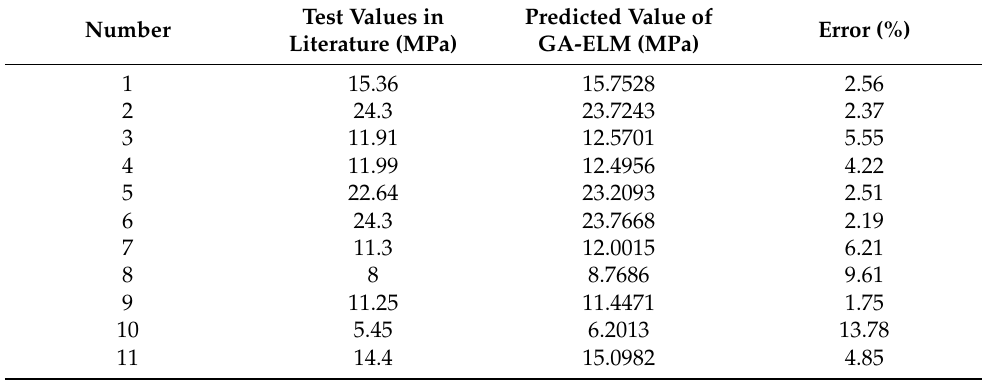
Table 5. The test set prediction